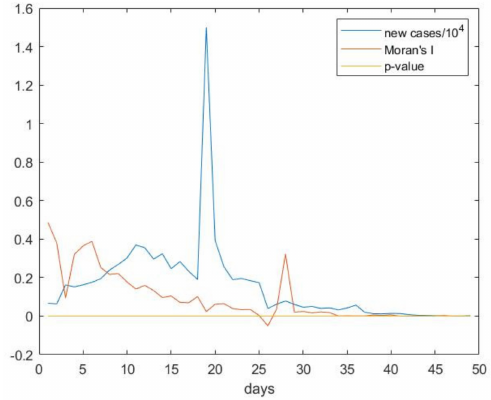
Figure 3. The daily new cases and Moran’s I.